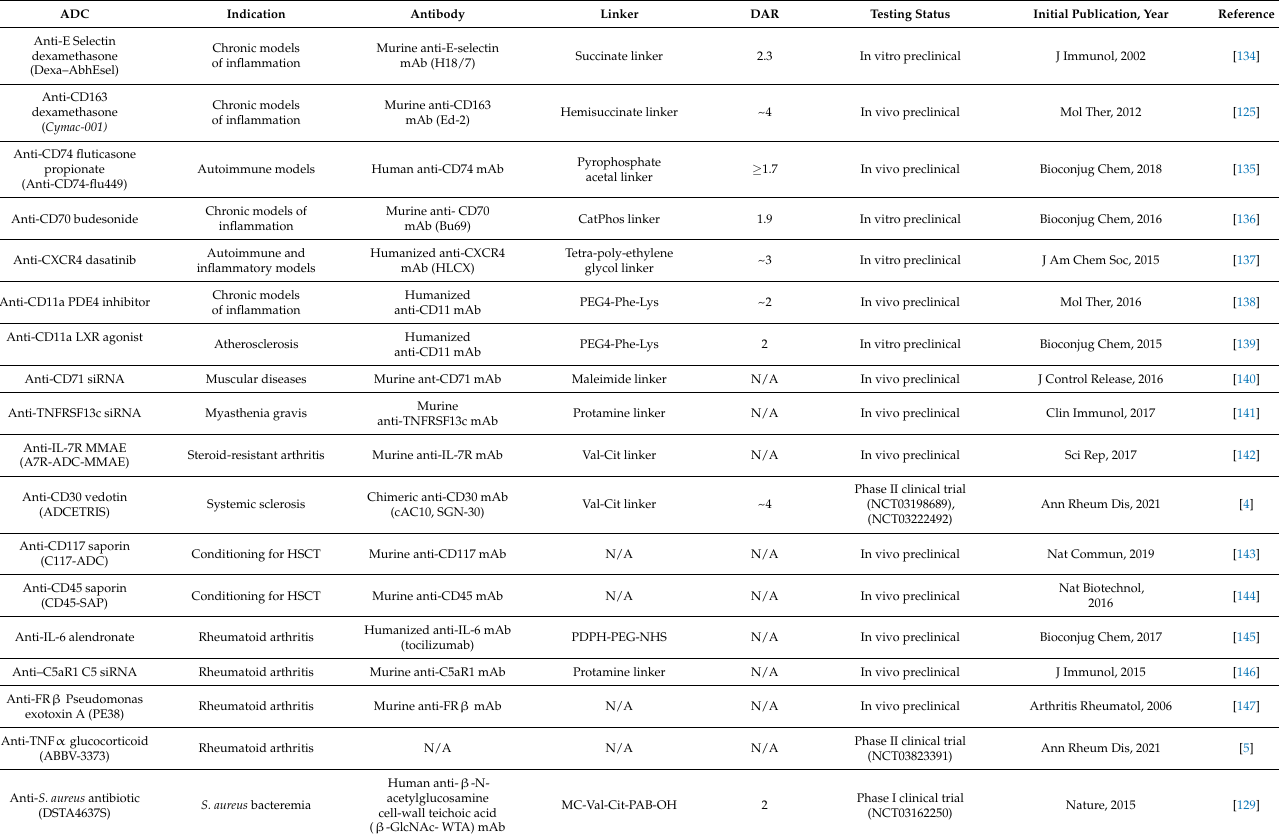
Table 3. Summary of ADCs tested for non-oncological